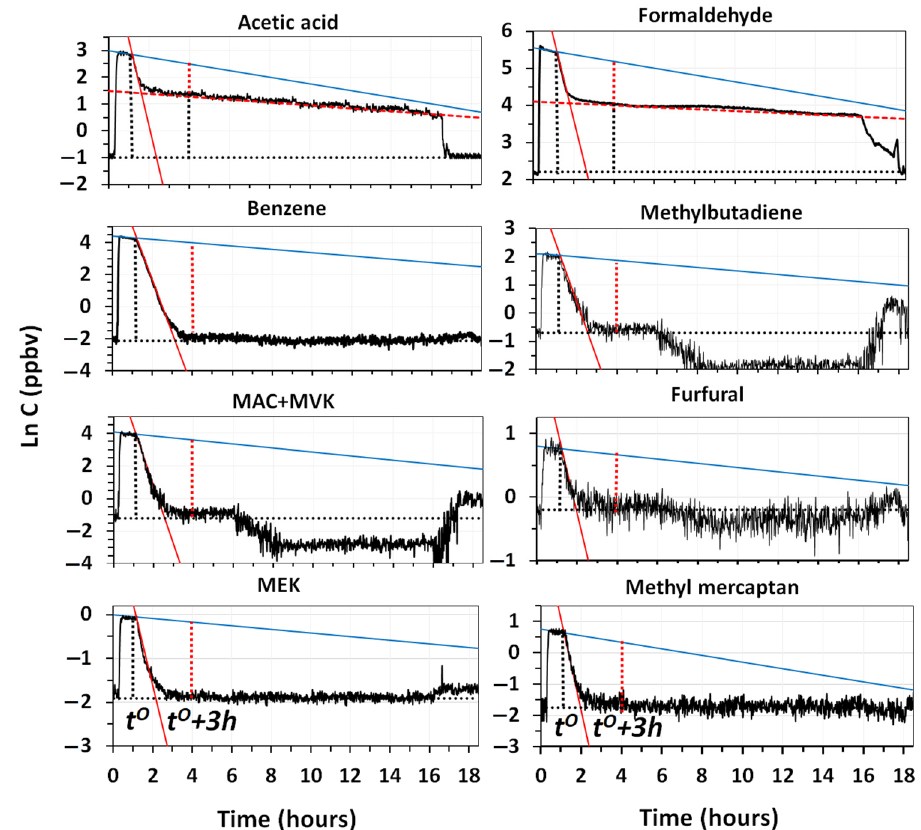
Figure 9. Semi-logarithmic plots of selected VOCs vs. time recorded in the testing room during an experiment performed with diesel exhaust emission, using the SANINDOOR as air cleaner. The meaning of the solid lines in blue and red is the same as in the previous figures. For the sake of clarity, only the starting time of cleaning, 𝑡 (cid:2868) , and the time at which the net removal VOC was determined (𝑡 (cid:2868) + 3ℎ) , are reported in the Figure. The dotted vertical segment in red, indicates the net amount of each VOC removed by the cleaner after 3 h, whereas the vertical dotted segment in black indicates the residual amount to remove. The trends of the natural decay of VOCs not completely removed from the room are also are indicated by the dotted lines in red.